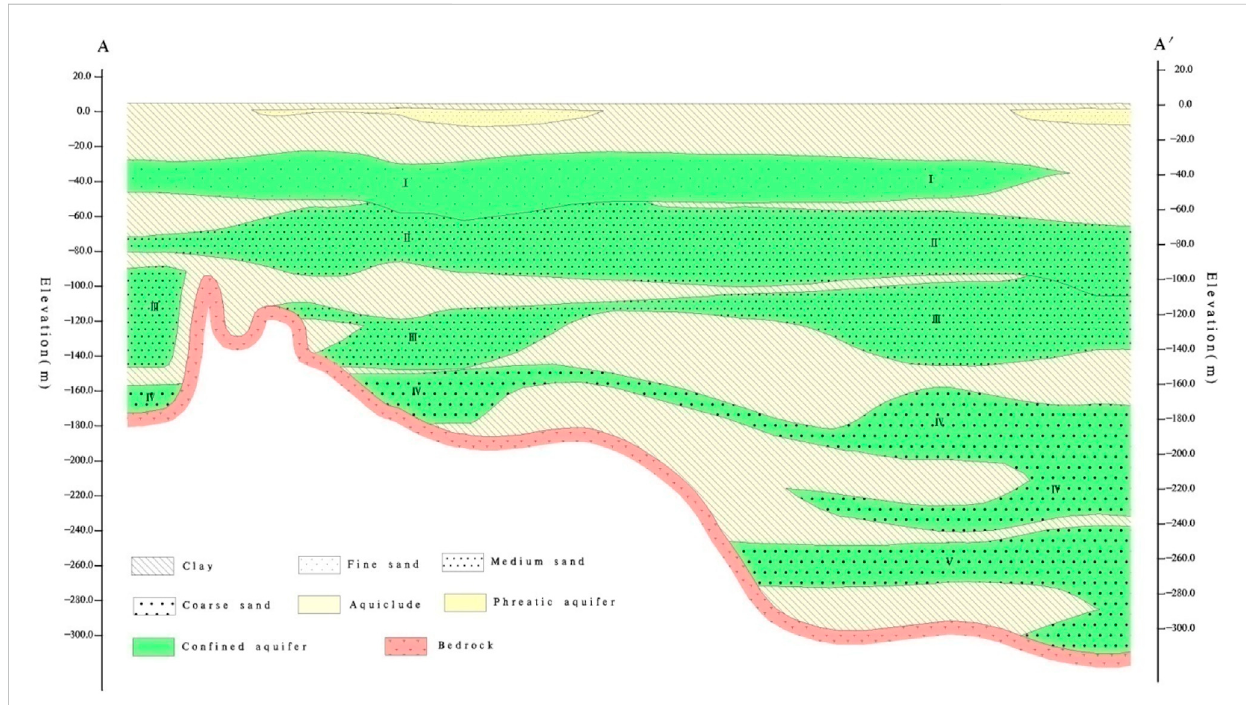
FIGURE 2 Cross-section showing hydrological conditions along the (A,A 9 ) transect.